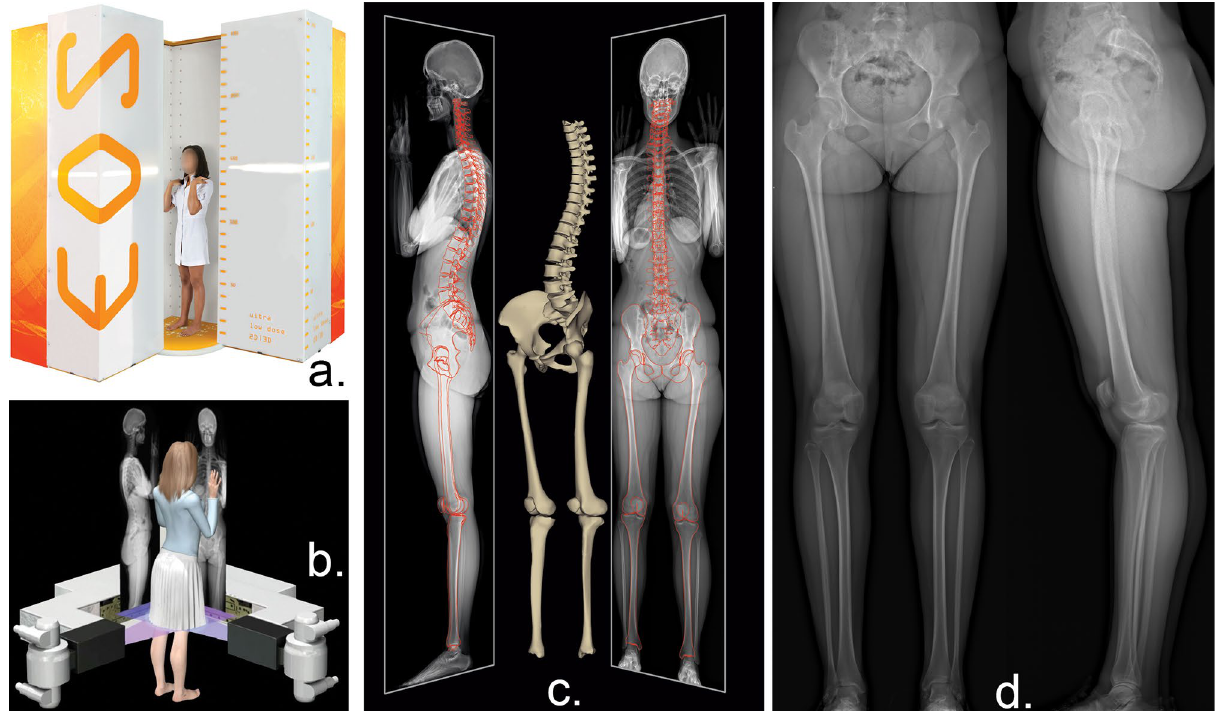
Figure 1. The EOS 2D/3D Imaging System. ( a ) The EOS 2D/3D Imaging System and the typical positioning during examination (source: www. eos- imagi ng. com). ( b ) The basic operation of the imaging system: upright biplanar slot-scanning X-ray imaging (source: www. eos- imagi ng. com). ( c ) 3D reconstruction opportunities of the lower limb and spine (source: www. eos- imagi ng. com). ( d ) Example of a typical EOS 2D/3D lower limb image-pair used in this